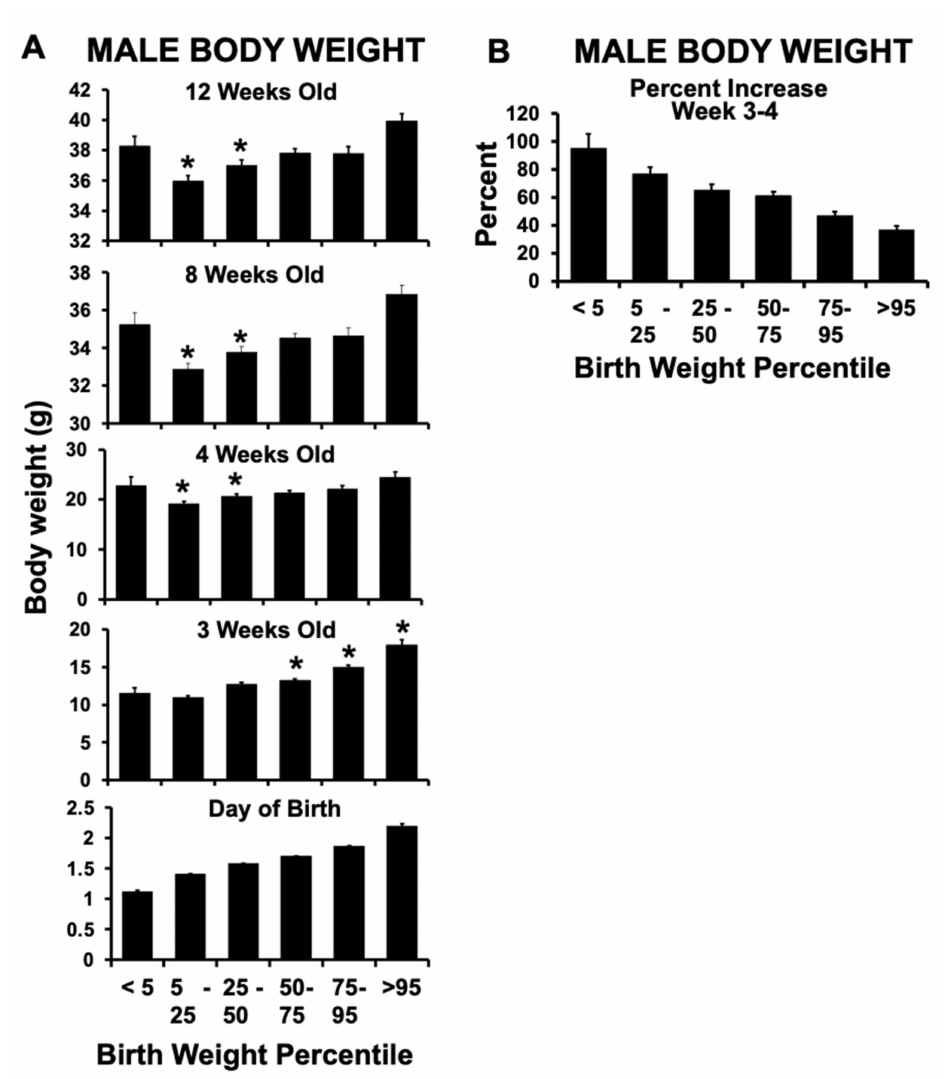
Figure 2. Body weight and growth of Block 1 male mice. ( A ) Body weights of male mice produced in 52 litters by Block 1 hemi-ovariectomized females based on birth weight categories, from the ≤ 5th percentile to ≥ 95th percentile. Beginning at postnatal week 3 (weaning), body weights were measured for all surviving male offspring until postnatal week 12. ( B ) the percent increase in body weight for these males during the first week of free-feeding after weaning (week 3–4). A subset of these Block 1 males (from IUGR, median and macrosomic birth weight categories) were retained after week 12 for additional studies. (See Table S1). * p < 0.05 compared to males from the bottom 5th percentile (IUGR males). Values are mean ±